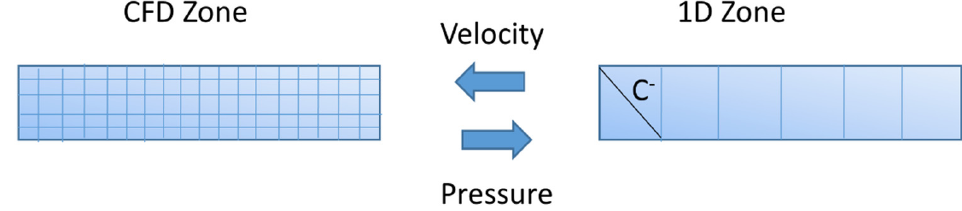
Figure 2. Data exchange between 1D and 3D computational zones.